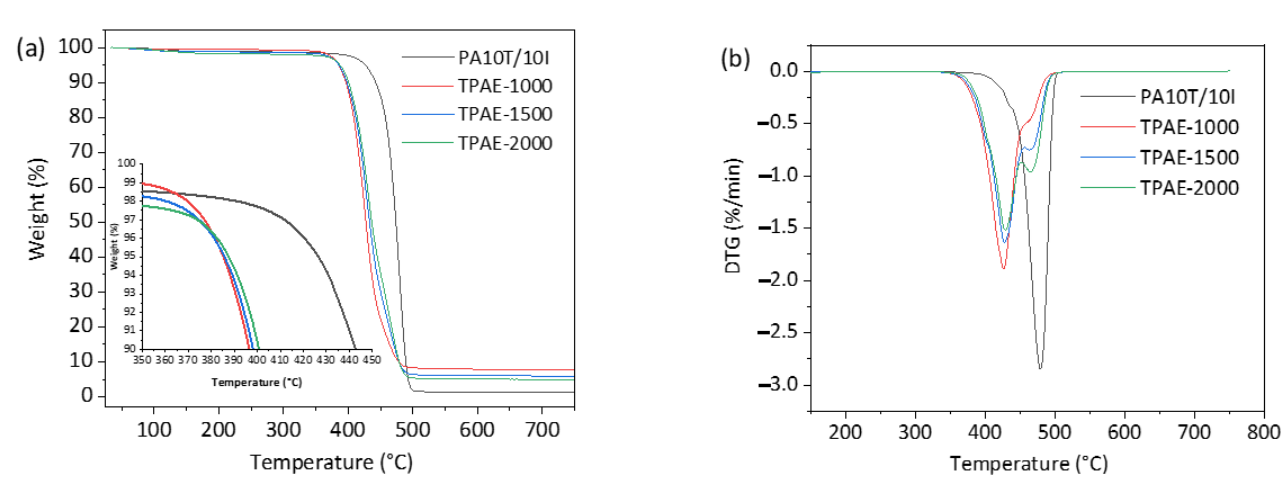
Figure 4. TGA ( a ) and DTG ( b ) curves of TPAEs and PA10T/10I at a heating rate of 10 °C min −1 in a nitrogen atmosphere.